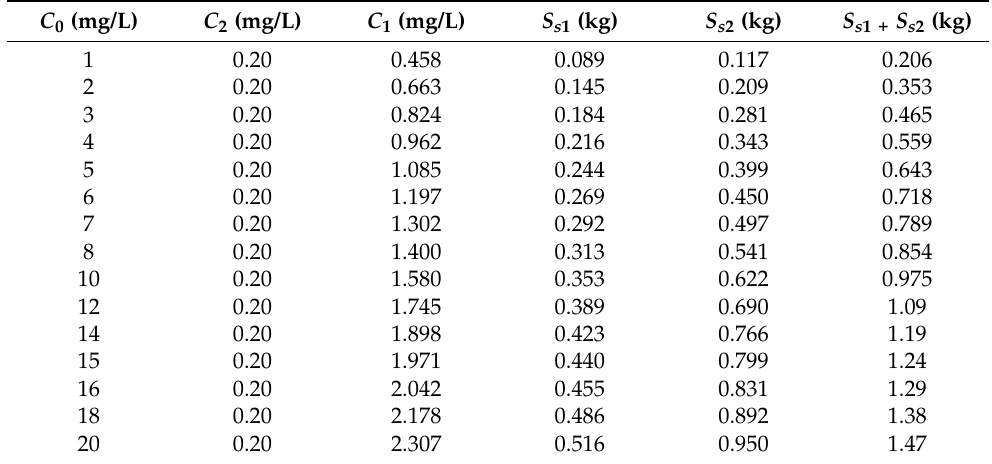
Table 6. Minimum total quantity of date stone acid-treated activated carbon to remove IBU using the Langmuir – Freundlich model to achieve C 2 = 0.20 mg/L.